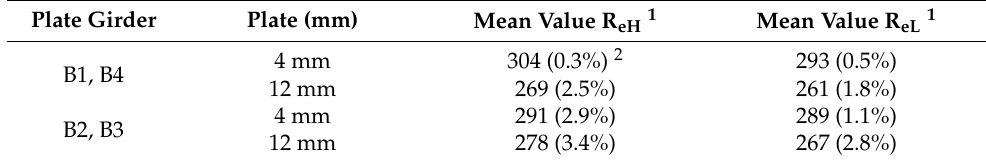
Table 2. Mechanical properties of steel—upper yield stress (R eH ) and lower yield stress (R eL ) (MPa).